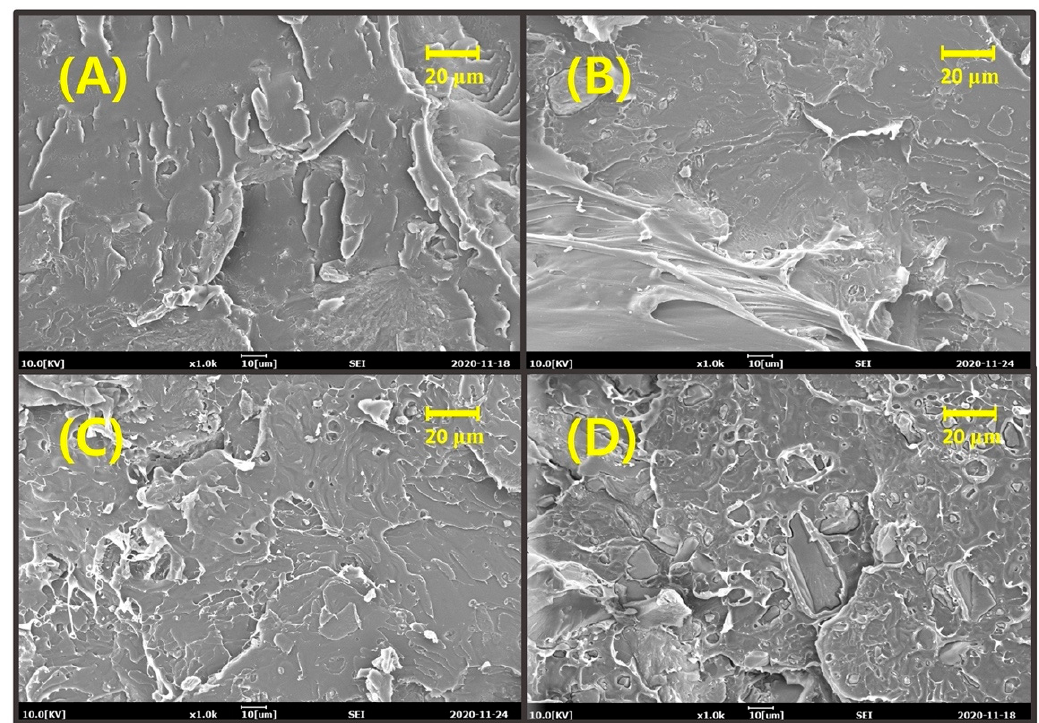
Figure 3. SEM micrographs of cryogenically fractured surfaces: poly(lactic acid) (PLA)-based biocomposites with COOH-lignin ( A ) 5 wt.%, ( B ) 10 wt.%, ( C ) 15 wt.%, and ( D ) 20 wt.%, respectively.